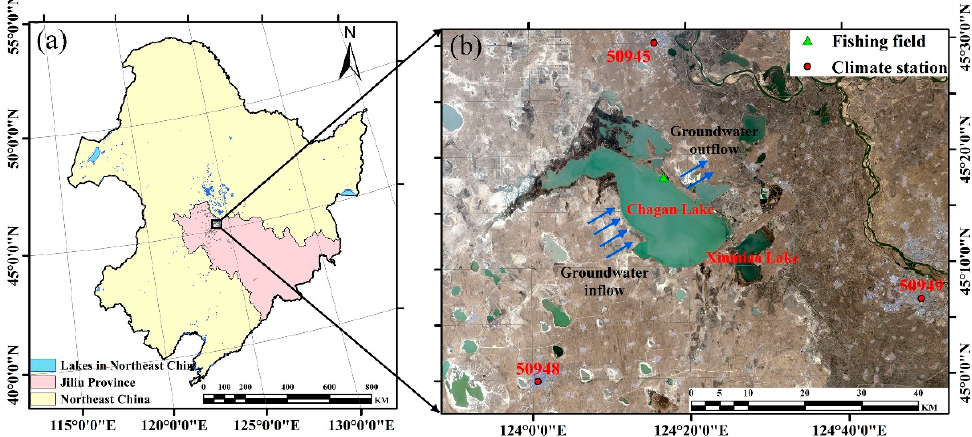
Figure 1. The geographic location of Chagan Lake, China: ( a ) geographic map of Northeast China; ( b ) the spatial coverage of Chagan Lake using the Landsat image on April 15, 2019. Three climate stations (red circle) are involved, including Da’an (50945), Qian’an (50948), and Qianguo (50949). The Chagan Lake belongs to a mid-temperate, semi-arid, continental monsoon climate with well-marked seasons [32,33]. The region has an average temperature of 5.5 ◦ C, total precipitation of 450 mm, and an annual sunshine duration of 2880 hours [33]. The average runoff and evaporations are 451 and 1206 mm, respectively [24]. In winter, the Chagan Lake begins to freeze in late November and stops melting in the middle of April. The ice cover exists for as long as 150 days with a completely frozen duration of 130 days [25]. The ice thickness ranges from 0.8 m to 1.1 m [35]. The primary water source of Chagan Lake mainly consists of precipitation, groundwater, and irrigation discharge from three adjacent districts, including Da’ an, Qian’an, and Qianguo [36]. The inflow and outflow of